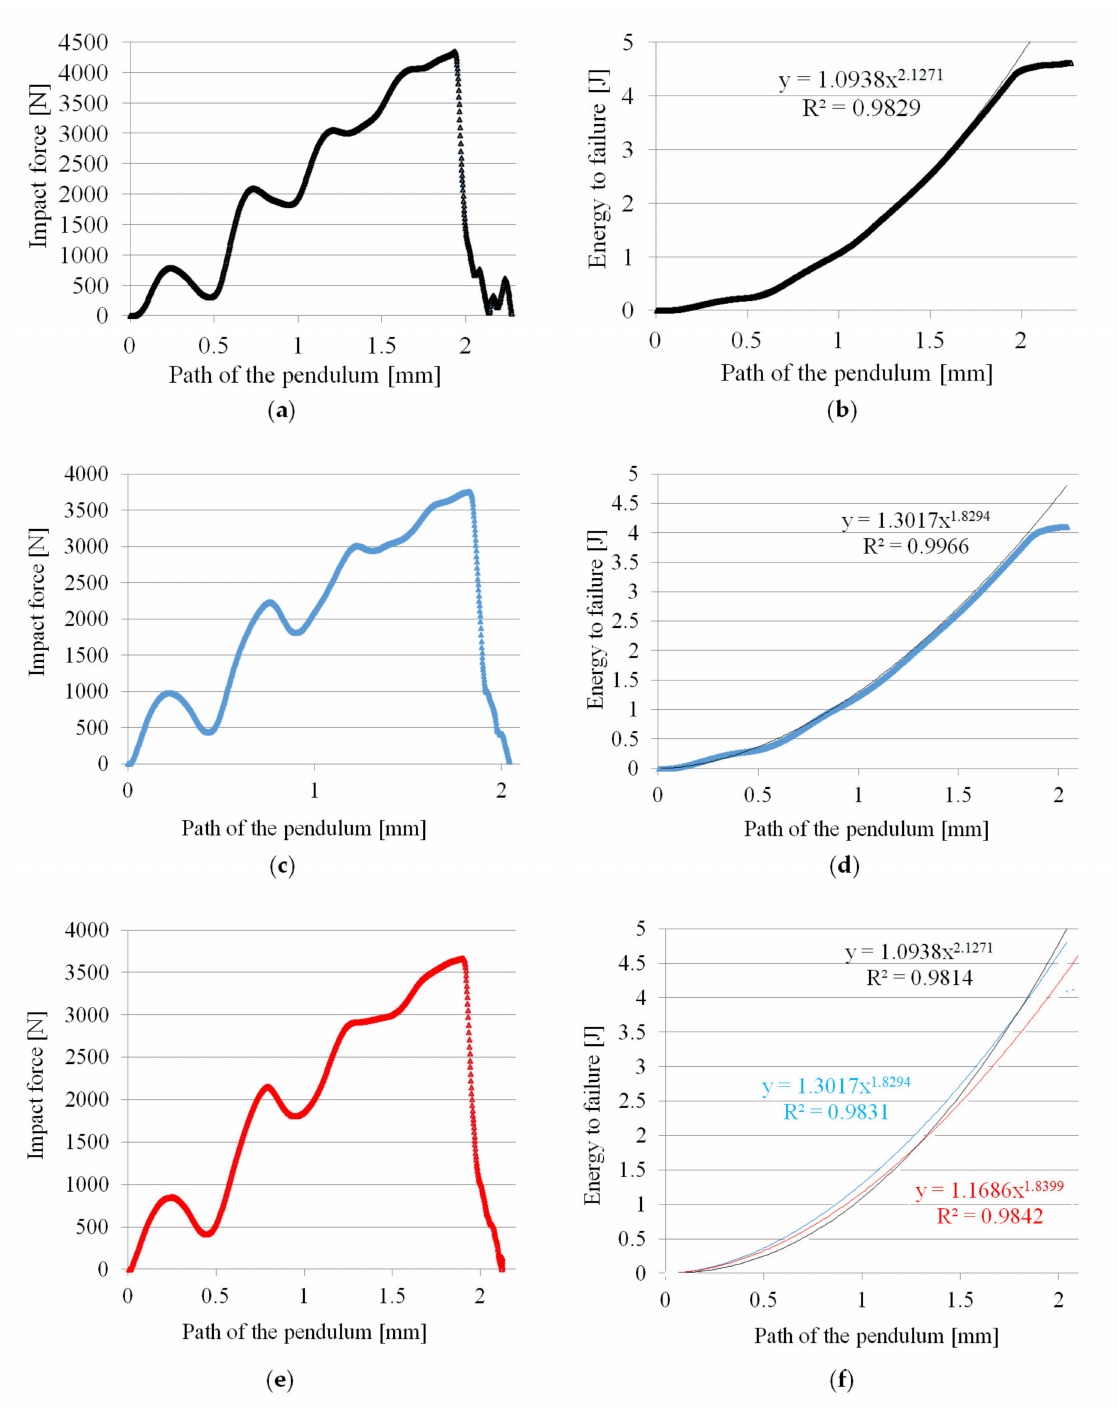
Figure 19. Courses of the impact force and the cumulative energy of failure during the impact tests of PA66 GF30 samples with a thickness of 8.4 mm: ( a , b ) unfoamed moldings A, ( c , d ) foamed moldings B, ( e , f ) foamed moldings